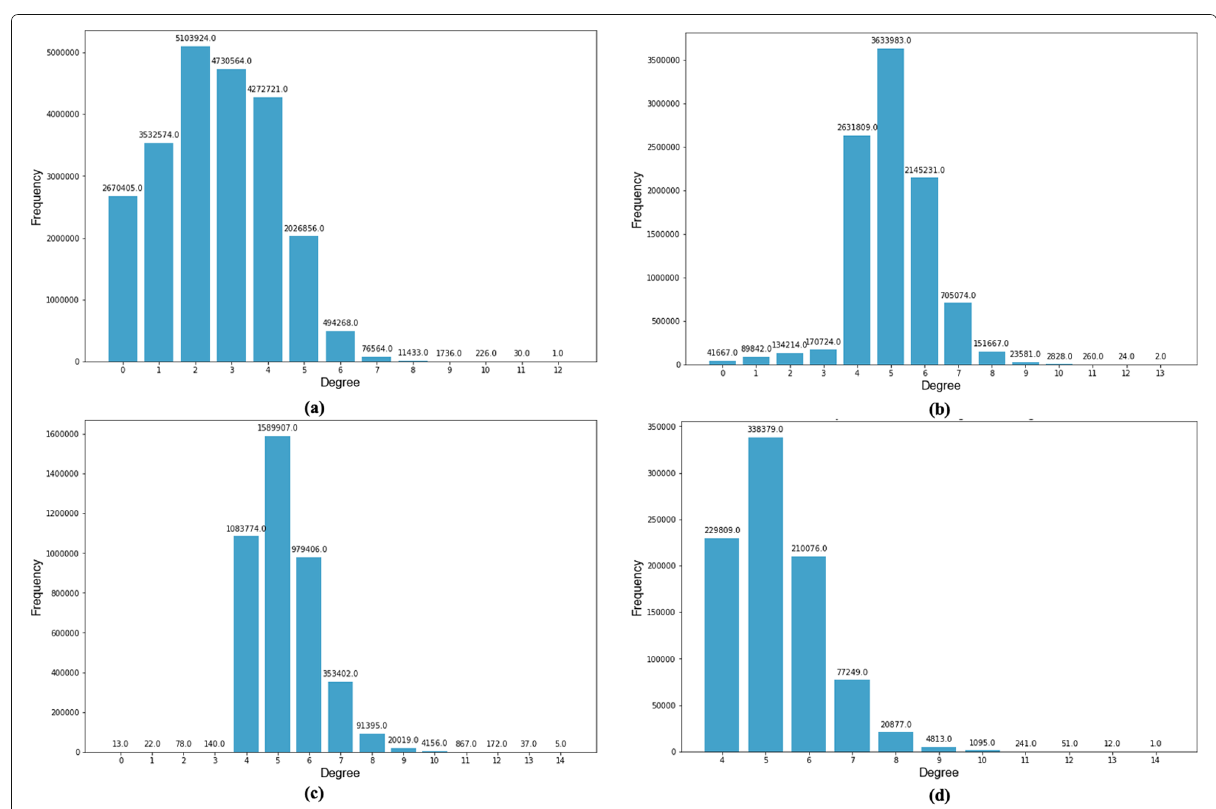
Fig. 7 Various Social Networks from Our Synthetic Population Method: ( a ) Household; ( b ) Work; ( c ) School; ( d ) Daycare